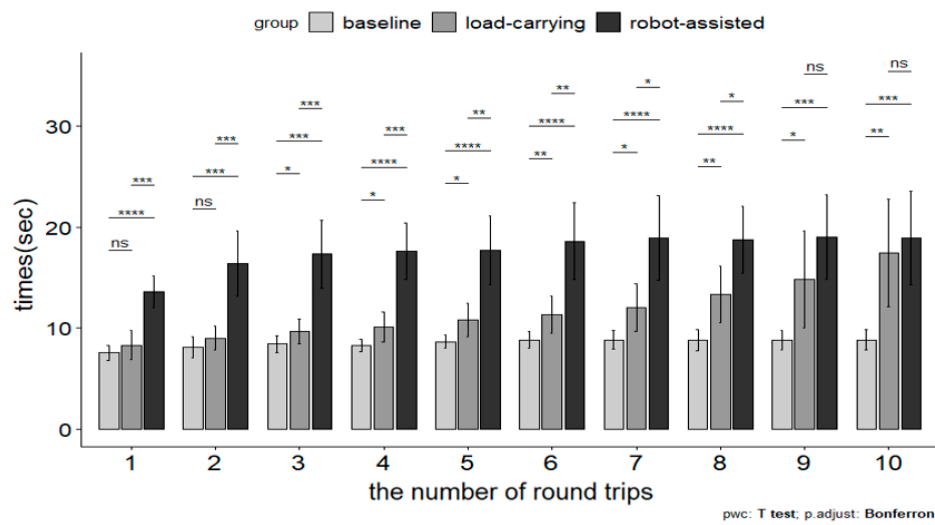
Figure 6. Result of post hoc comparisons. p -values (ns: p > 0.05; *: p ≤ 0.05; **: p < 0.001; ***: p < 0.0001).